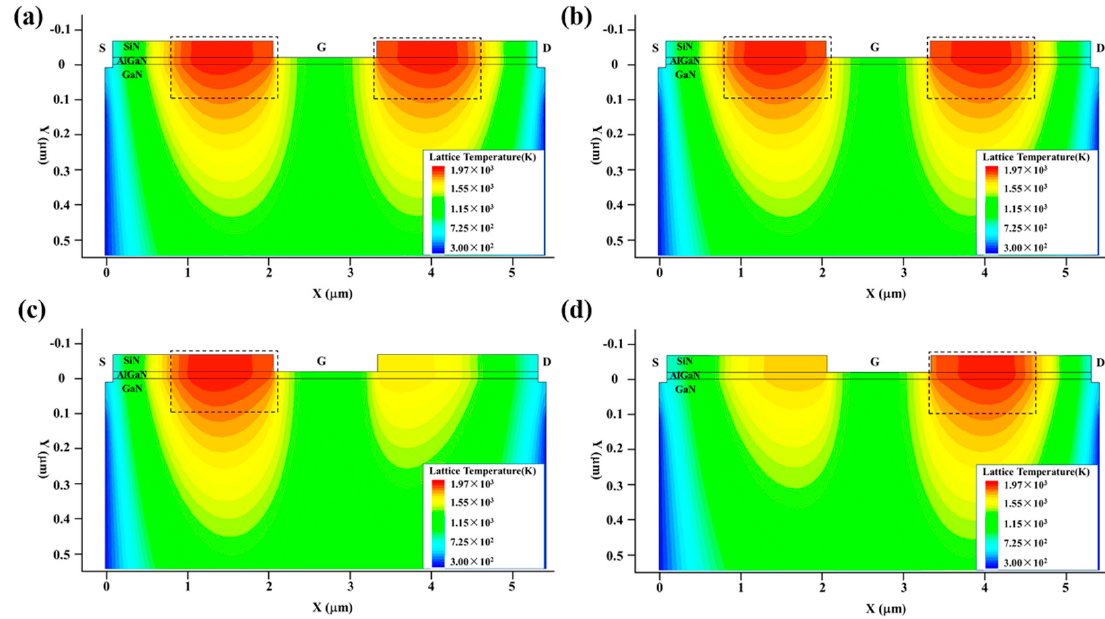
Figure 16. The thermal distribution of the GaN HEMT at the moment of burnout in different external circuits: ( a ) R = 0 Ω ; ( b ) R G = 1 k Ω ; ( c ) R D = 1 k Ω ; ( d ) R S = 1 k Ω .